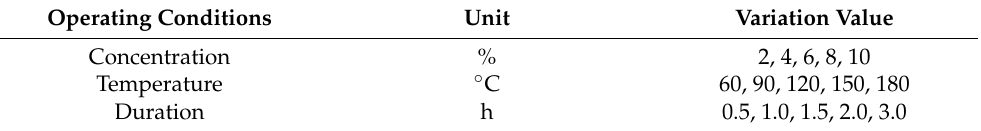
Table 2. Operating conditions of the extraction process using H 2 SO 4 and NaOH solvents. Operating